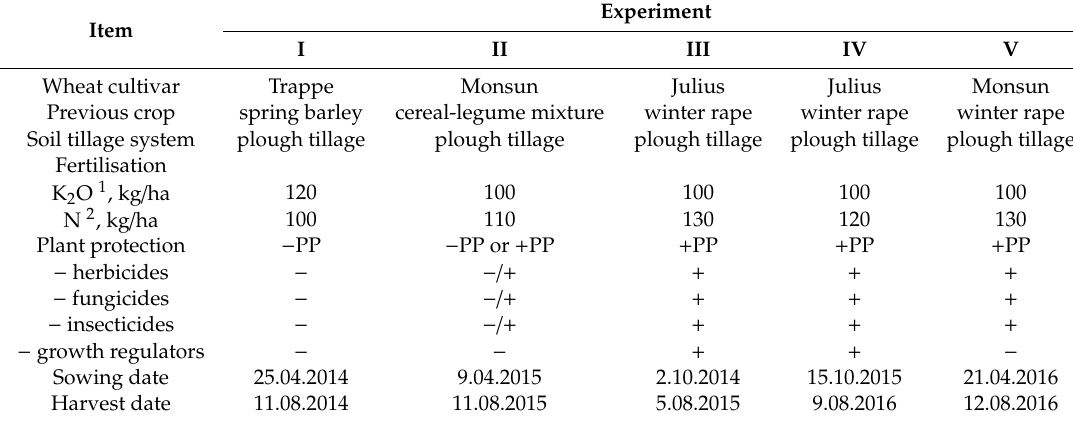
Table 4. Basic agricultural data for the experiments.